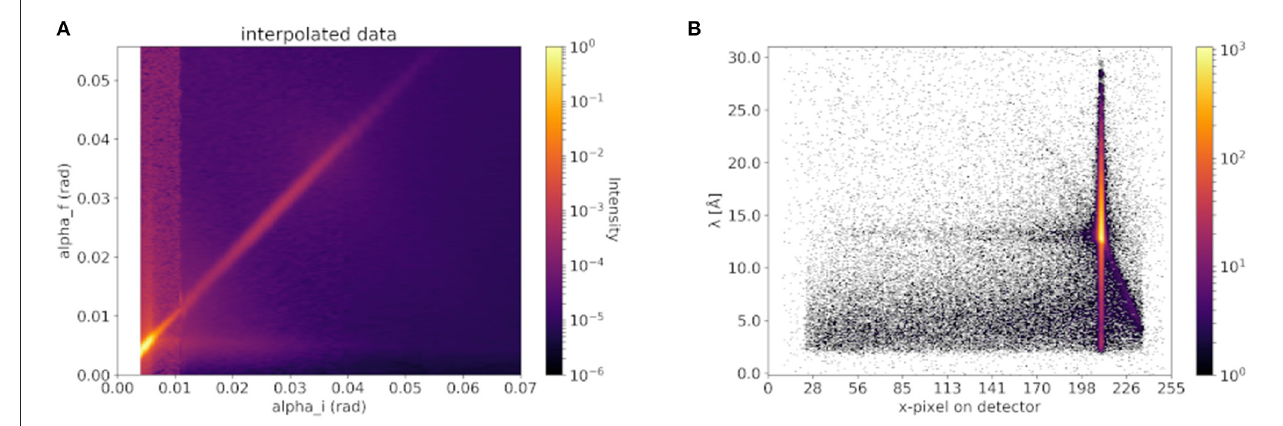
FIGURE 5 | Off-specular signal of vesicle coated membranes seen by (A) classical monochromatic and (B) TOF neutron reflectometer. In (A) an exemplary measurement at the classical monochromatic instrument MARIA (Mattauch et al., 2018) from an EAE-modified sample of our previous paper (Krugmann et al., 2020b) is shown. And in (B) an exemplary measurement of an EAE modified membrane at the TOF reflectometry mode using an incident polychromatic neutron beam of the D17 instrument is shown as